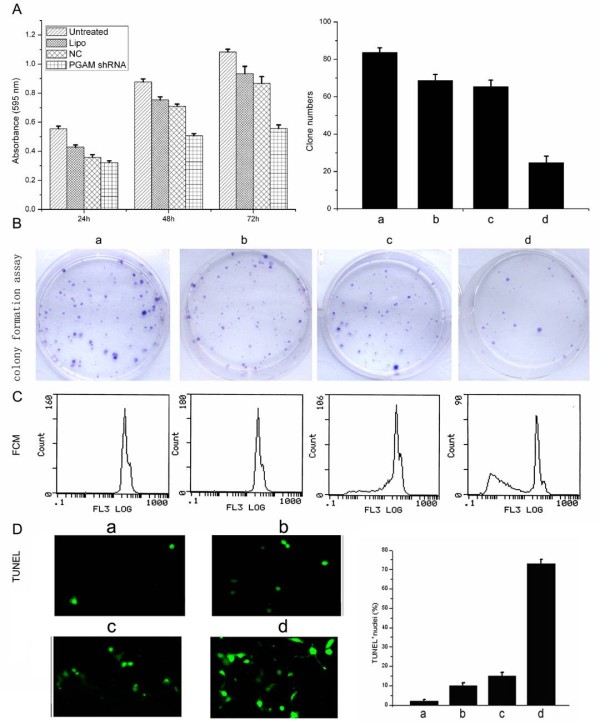
Suppression of PGAM1 by PGAM1-shRNA-a resulted in cell growth arrest and induced apparent apoptosis in vitro. (A) Evaluation of the antiproliferation effects using MTT assay. Inhibition of cell growth by siRNA against PGAM1 was in a duration-dependent manner and the proliferation rate was decreased to 48.6% at 72 h posttransfection. (B) Survival rates of hepatoma cells were examined by colony formation assay. 24 h after transfection, cells were allowed to grow at a density of 300 cells/dish for additional two weeks before staining with Crystal Violet. (C) Flow cytometry analysis was performed and the subdiploid peak increased after 72 h of transfection (p < 0.05). (D) Cell apoptosis was assessed by TUNEL assay which showed a remarkably greater percentage of TUMEL positive nuclei of the PGAM1-shRNA-a group vs. the control group. a, untreated; b, Lipofectamine 2000; c, shNC; d, PGAM1-shRNA-a. Results represent the average of three independent experiments and data were shown as mean ± S.D.